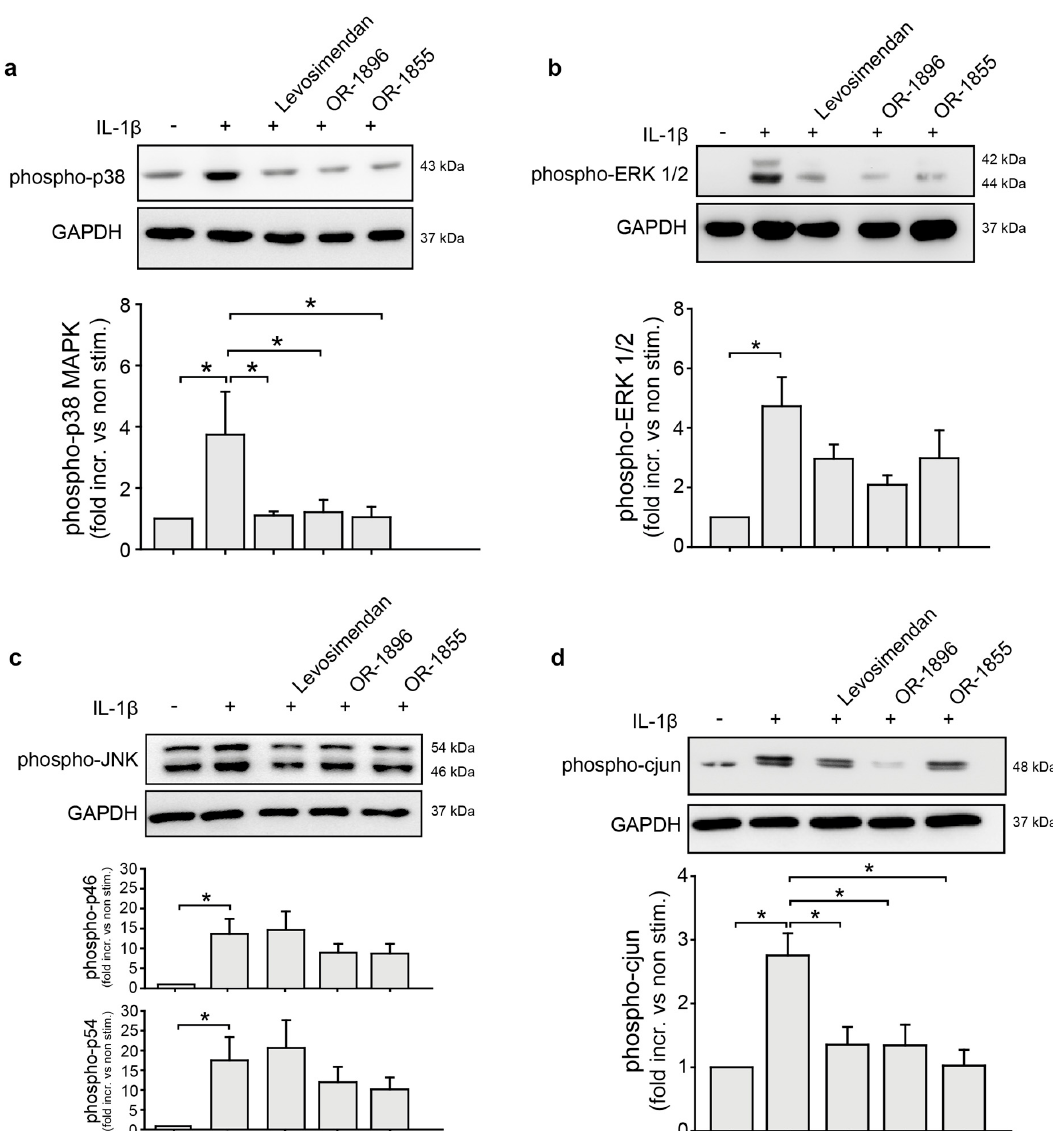
Figure 3. Impact of levosimendan, OR-1855, and OR-1896 on endothelial inflammatory MAPK sig- nalling. Endothelial cells were pre-incubated with levosimendan, OR-1855, OR-1896 (10 µM; 30 min.), or sham solution (DMSO v/v ) followed by stimulation with IL-1 β (10 ng/mL) for 30 min before lysis and subsequent western blotting. ( a ) Levosimendan, OR-1855, and OR-1896 decreased IL-1 β -dependent phosphorylation of p38 MAPK (n = 4). ( b ) Levosimendan, OR-1855, and OR-1896 de- creased IL-1 β -dependent phosphorylation of ERK1/2 MAPK (n = 4–5). ( c ) OR-1855 and OR-1896 diminished IL-1 β -dependent phosphorylation of JNK (n = 15), while levosimendan had no effect (n = 15). ( d ) Levosimendan, OR-1855, and OR-1896 decreased IL-1 β -dependent phosphorylation of cjun (AP-1) (n = 7). The graphs show protein band densities of phosphorylated forms of the MAP Kinases and cjun normalized to GAPDH (* p < 0.05).